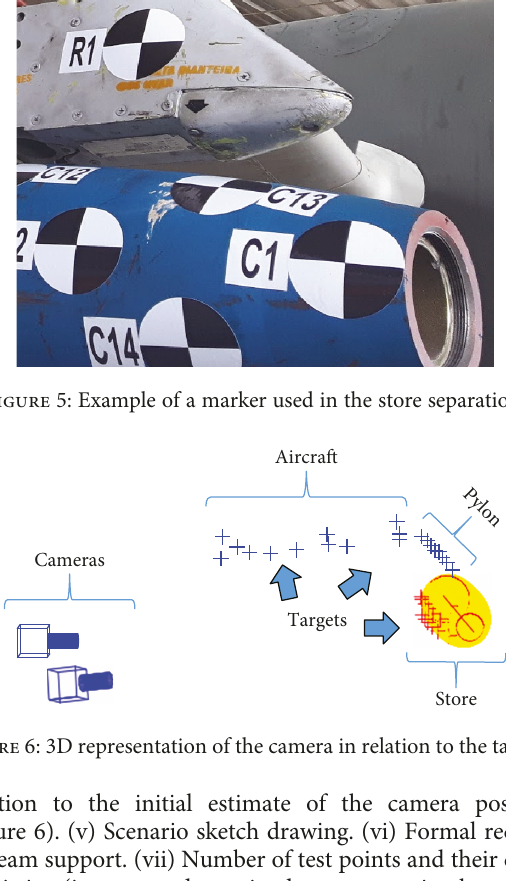
Figure 8: Lateral leveling A